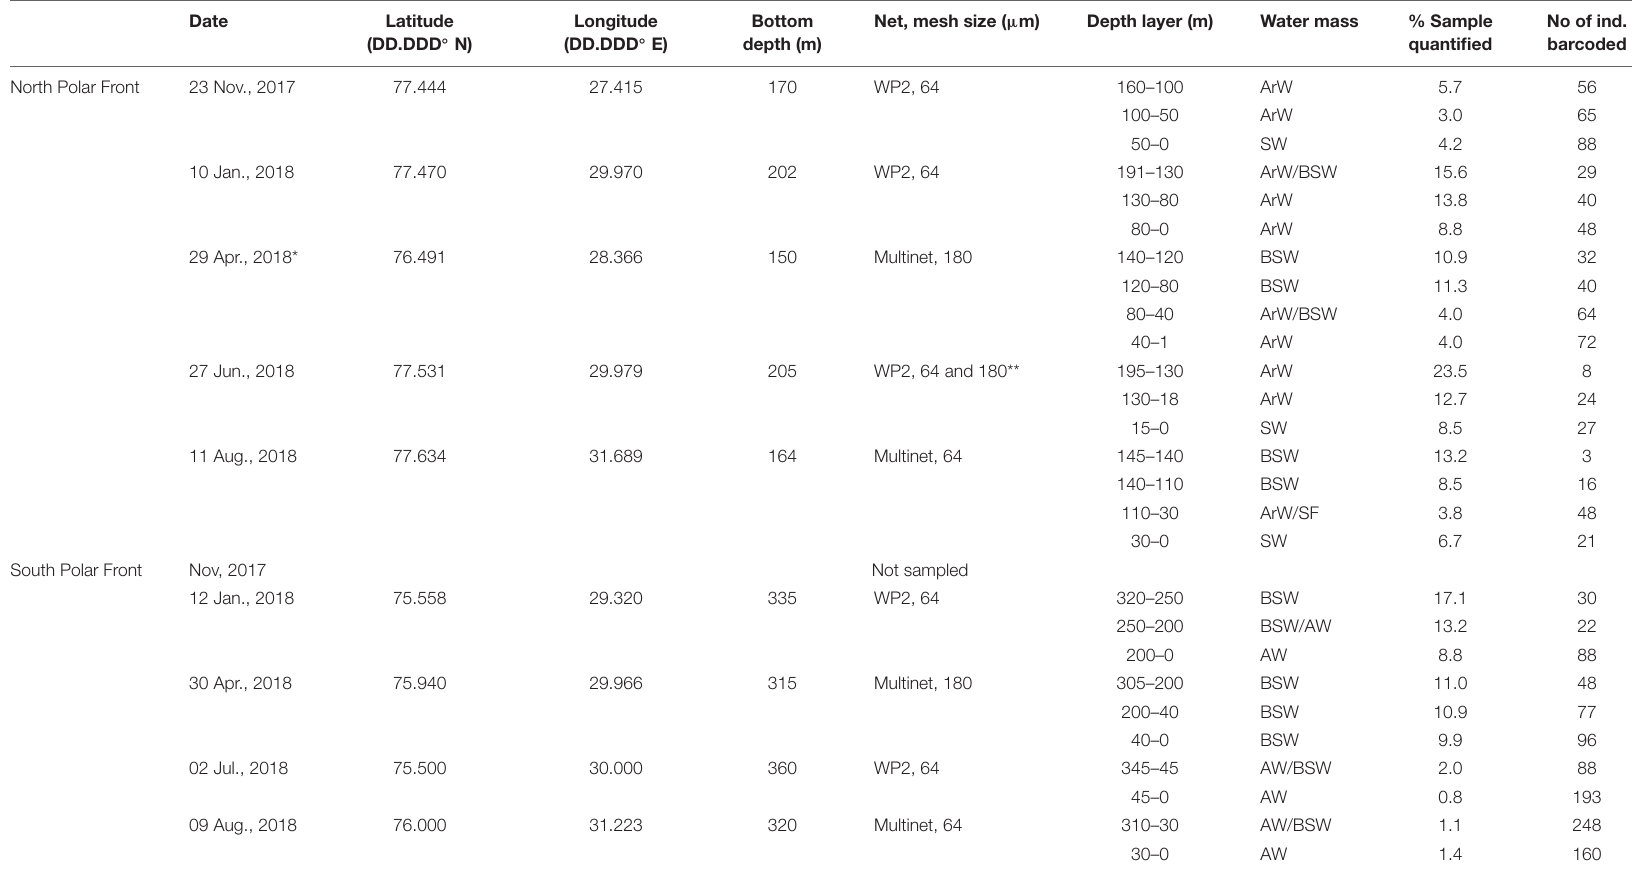
TABLE 1 | Sampling stations and gears for collection of meroplankton north and south of the Barents Sea Polar Front from November 2017 to August